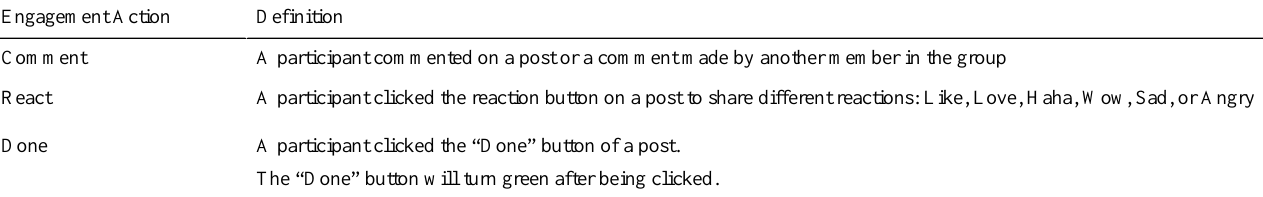
Table 1. Participant engagement actions on